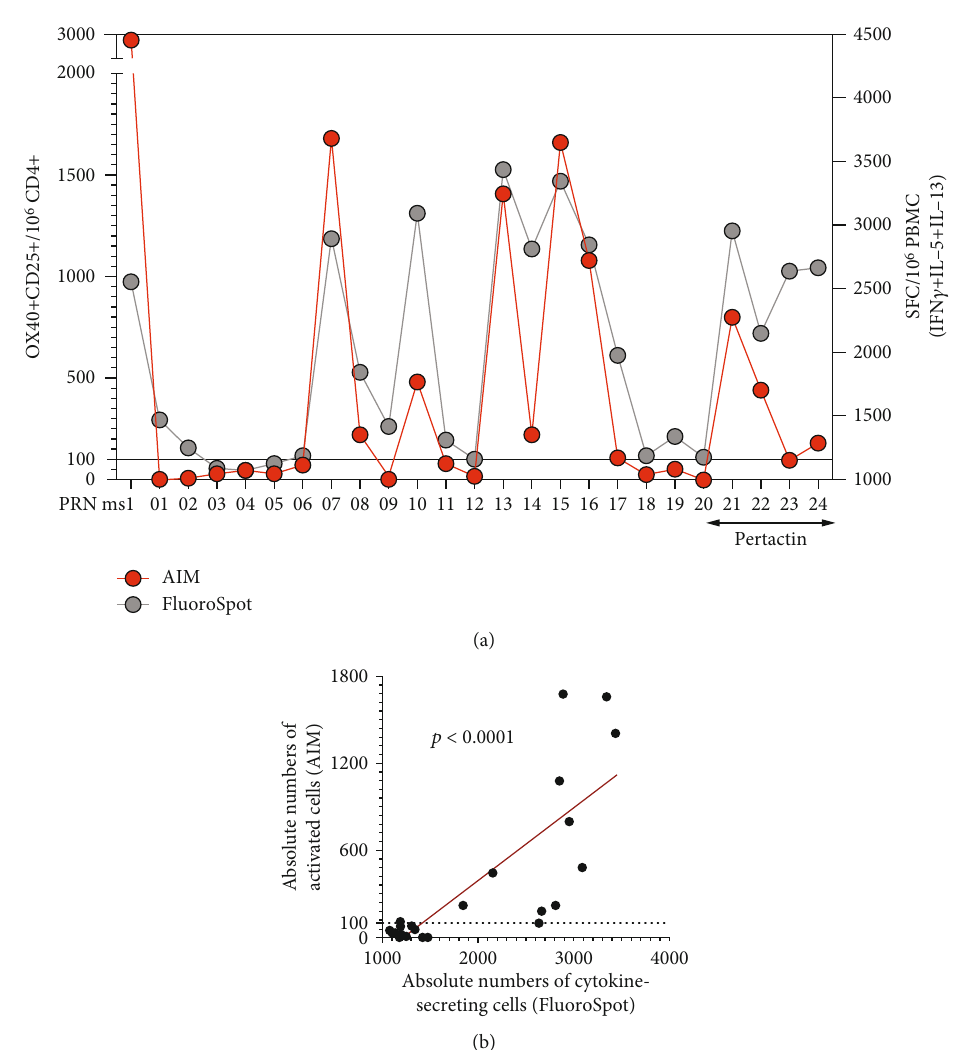
Figure 7: Correlation of results of the ex vivo AIM assay and 14 days restimulation assays. (a) The data show the overlay of the average of the individual peptide response as captured by either AIM or FluoroSpot assays for a selected mesopool deconvolution from a representative donor. (b) The best fi t of the peptide data set is represented by a linear regression line (red) and the p value expresses Spearman ’ s rank correlation coe ffi cient